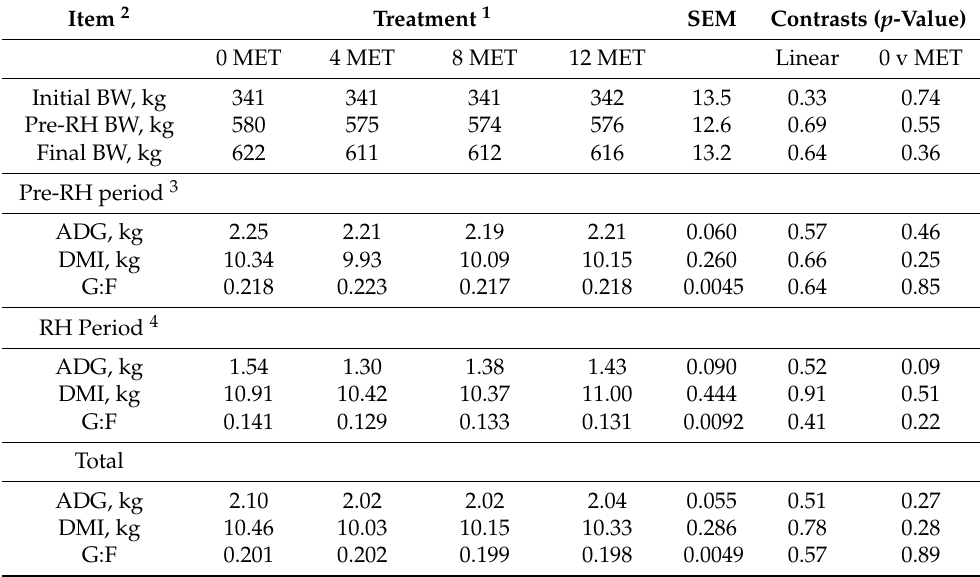
Table 4. Effects of encapsulated methionine (MET) supplementation on feedlot performance.